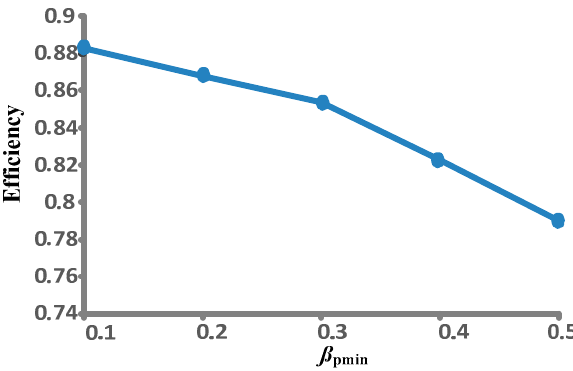
ffi ciency of the mechanical-hydraulic min on the e